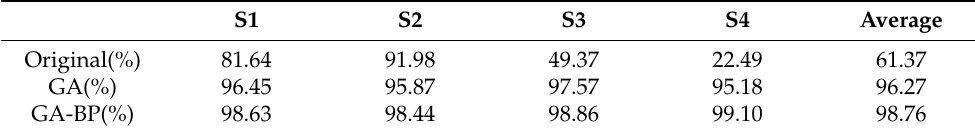
Table 2. Comparison of rolling force qualification rate, φ